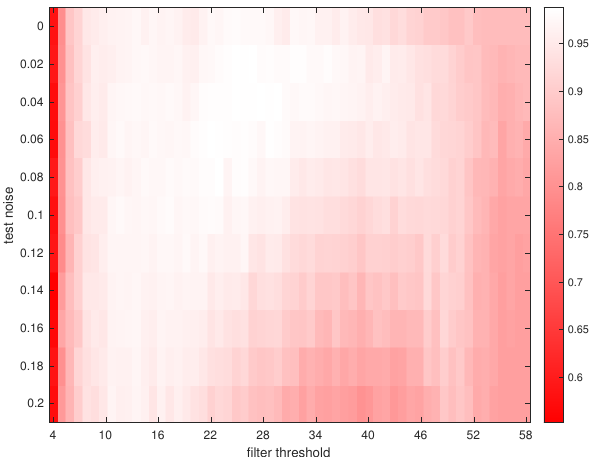
Figure 5. Performance score C p at diverse levels of noise with l = 8 for digit zero including all the whole-number thresholds.